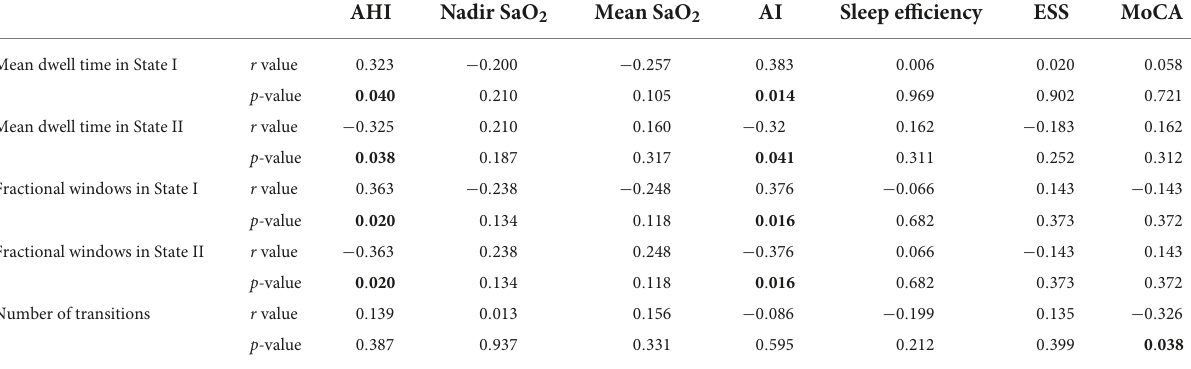
TABLE 3 Correlations between temporal properties of dynamic FNC and clinical characteristics in OSA-MCI patients. AHI Nadir SaO 2 Mean SaO 2 AI Sleep efficiency ESS